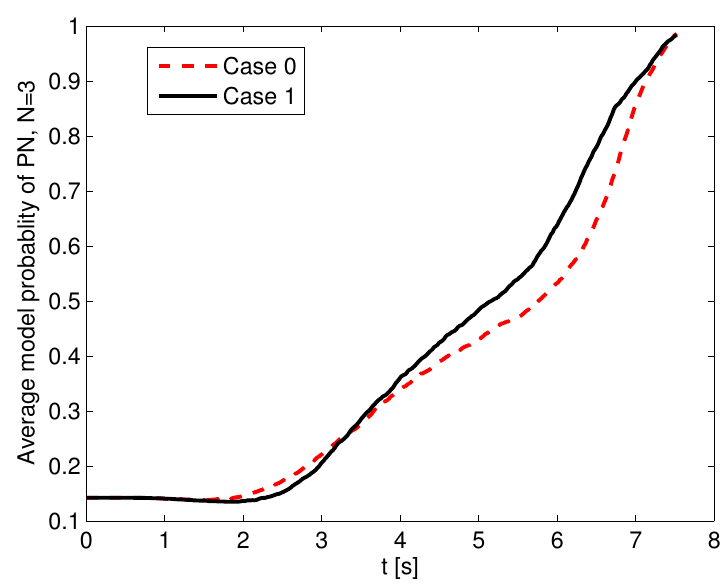
Figure 12. Average model probability of PN with N PN = 3 in Case 0 and Case